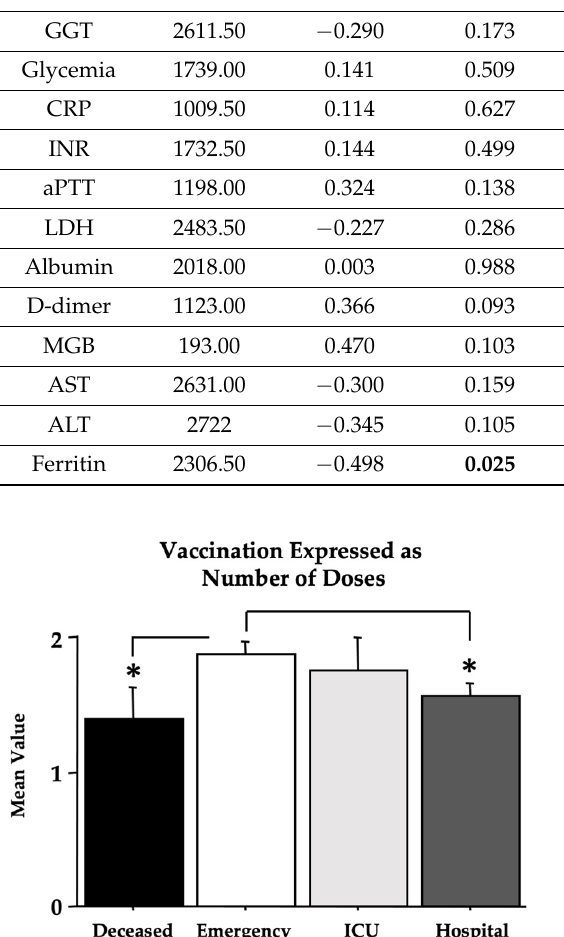
Figure 8. The vaccination effect is expressed as the number of doses of the vaccine. The error bars indicate pooled standard error means (SEM) derived from the appropriate error mean square in the ANOVA. The asterisks (* p < 0.05) indicate post hoc differences between groups.